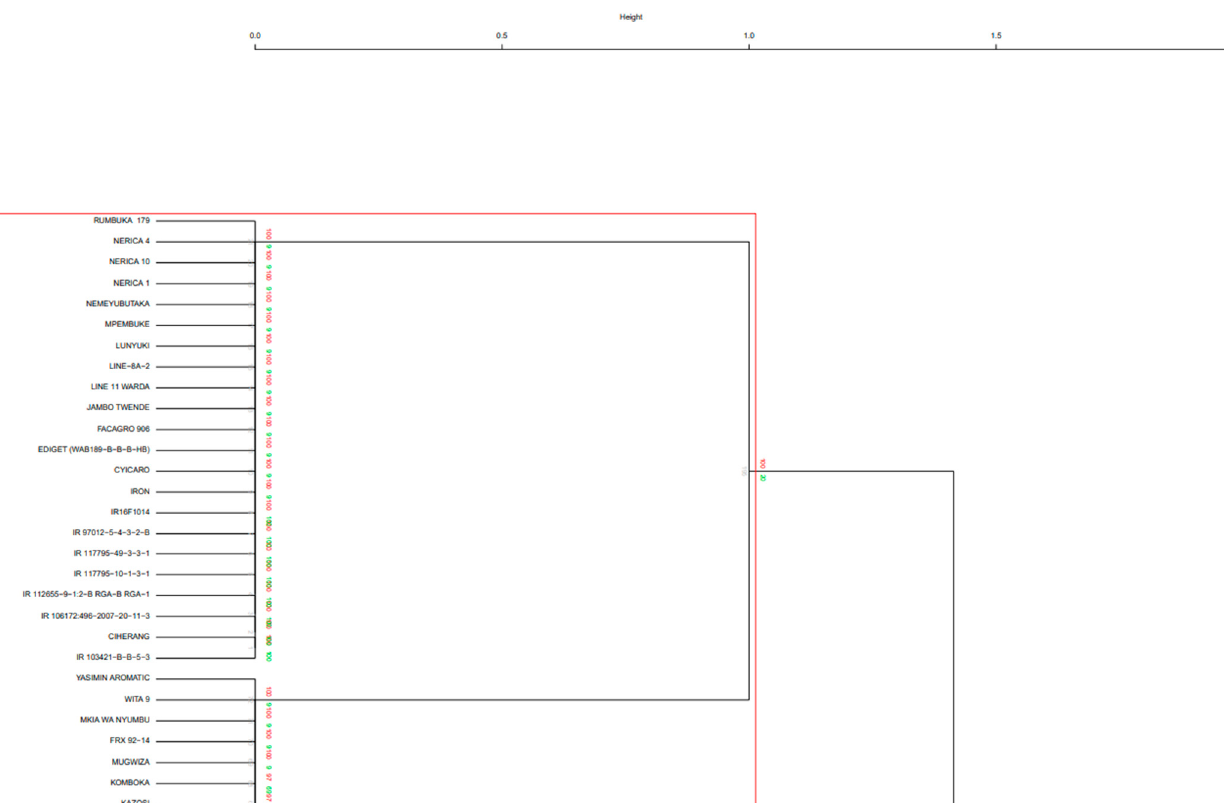
Figure A1. Weather data in the field at Gihanga from mid-July 2020 to early January 2021.